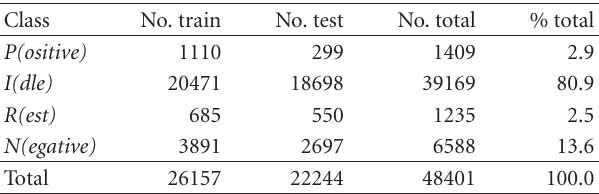
Table 1: Emotion classes and their word-based